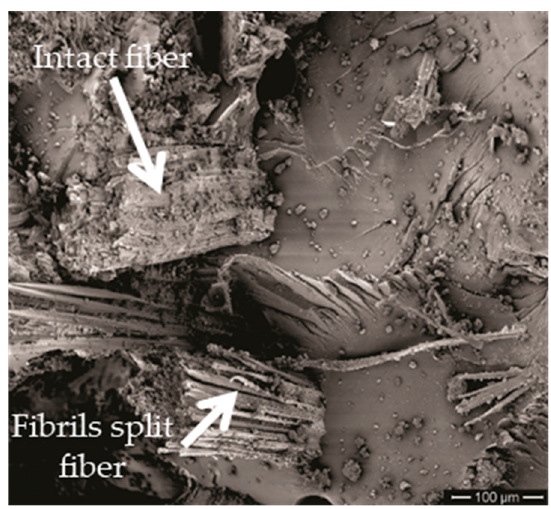
Figure 16. Fiber breaking of the GOCF composite fracture surfaces.